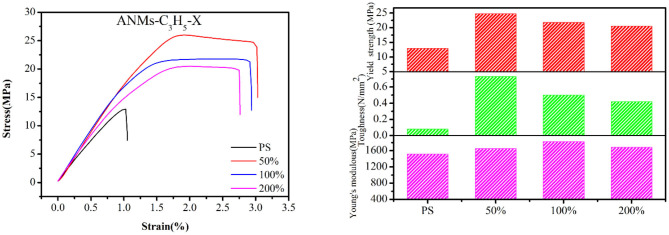
Mechanical testing diagram and results of pure PS and the ANMs-C3H5-X/PS.